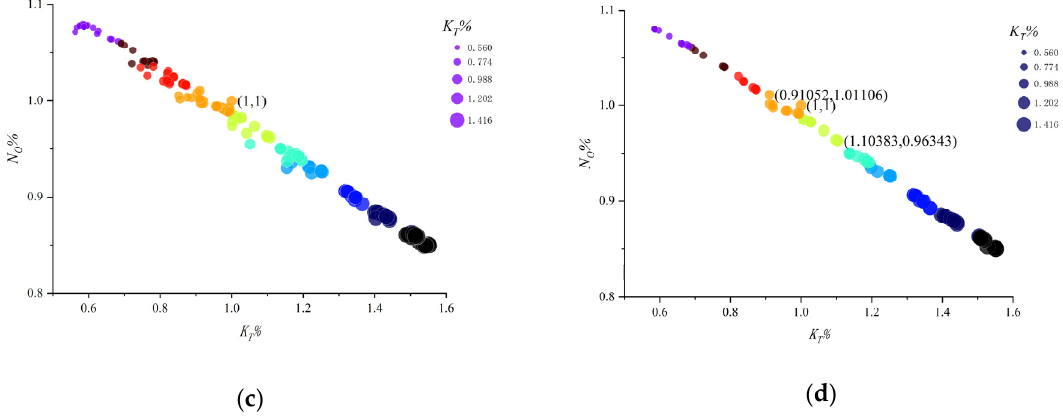
Figure 7. Pareto solution and distribution ( a ) SOBOL50 individual; ( b ) SOBOL best individual. ( c ) NSGA- II 200 individual. ( d ) NSGA- II best individual.